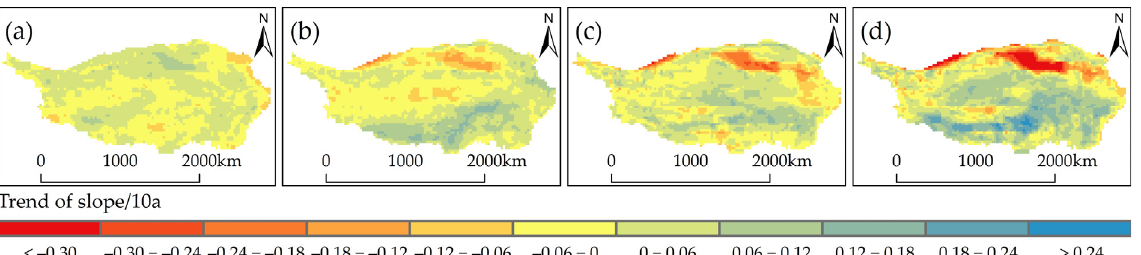
Figure 7. Spatial distribution of SPEI-12 trends on the TP from 2016 to 2099 under four climate scenarios: ( a ) RCP2.6, ( b ) RCP4.5, ( c ) RCP6.0, and ( d ) RCP8.5.